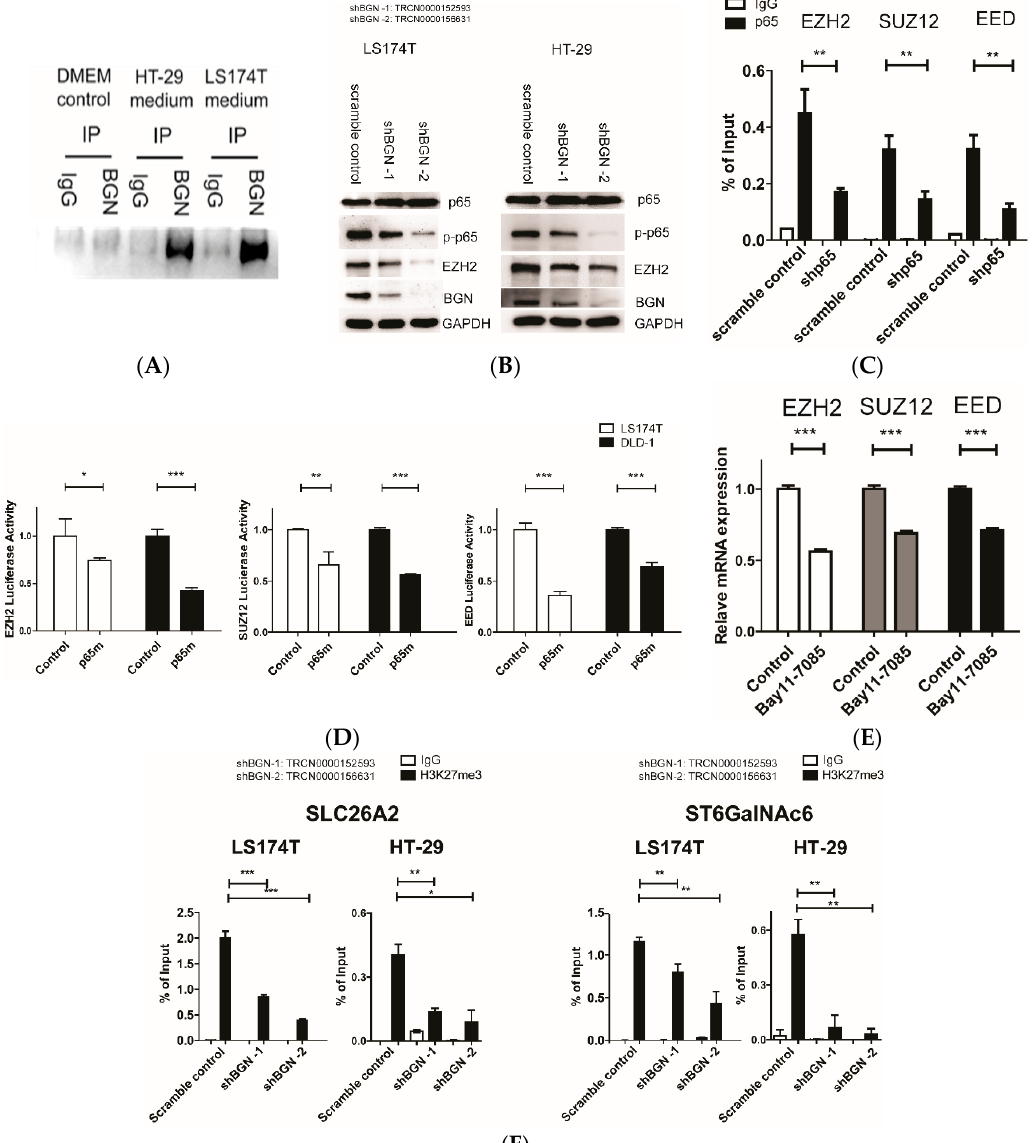
Figure 3. Suppression of BGN inactivates NF- κ B and decreases PRC2 activity in the promoter regions of SLC26A2 and ST6GalNAc6. ( A ) Western blot experiments of BGN in HT-29 and LS174T cultured medium. DMEM medium serves as a negative control. ( B ) Western blot experiments of phosphorylated p65 (p-p65) in LS174T and HT-29 after the introduction of shRNA for BGN. ( C ) ChIP / RT-qPCR results of p65 levels in EZH2, SUZ12, and EED regulatory regions in DLD-1 cells. ( D ) Mutational analysis